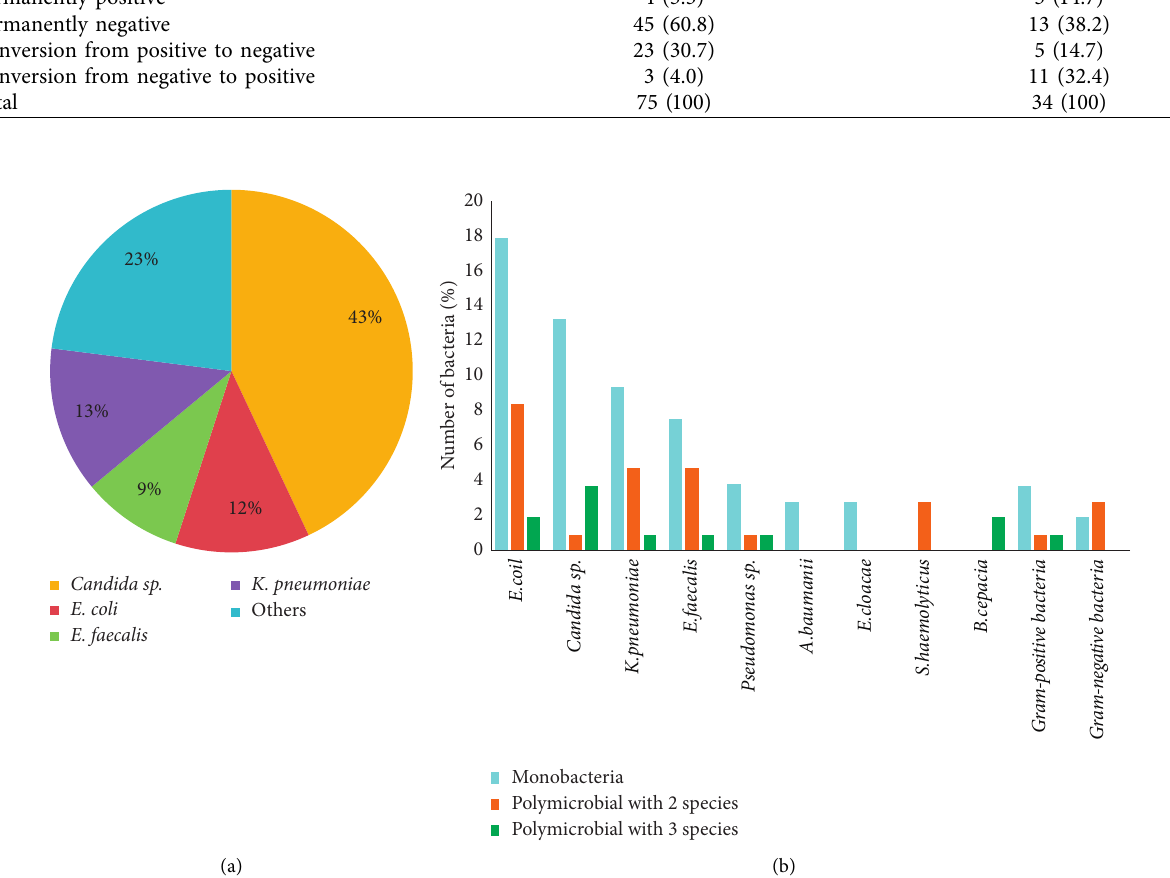
Table 2: Bacteriuria status on pre- and posturethral catheterization with the usage of antibiotics. Bacteriuria pre- and posturethral catheterization Usage of antibiotics ( n , %)